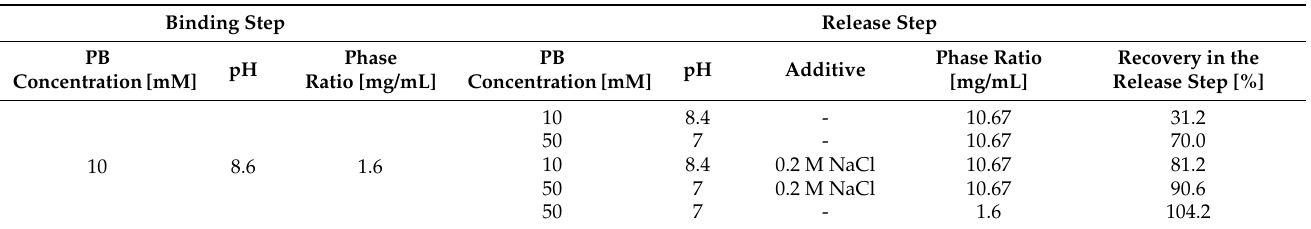
Table 1. Efficiency of the protein removal from Lys-PMNPs using different buffer solutions and phase